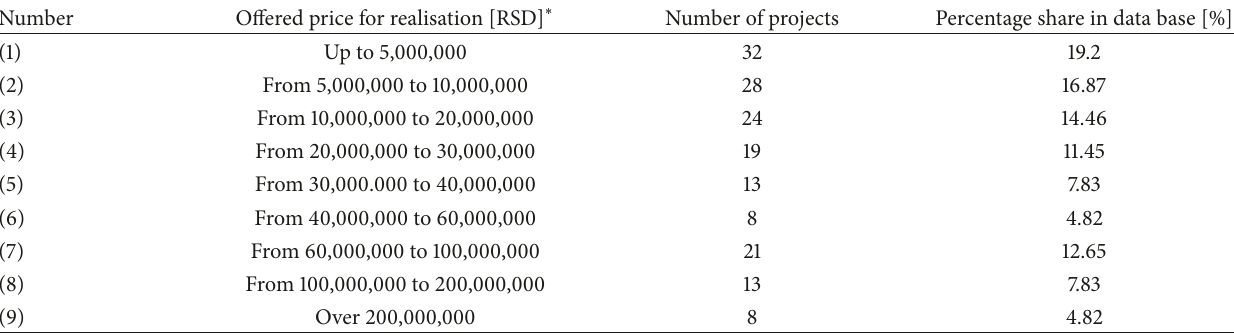
Table 3: Number of projects depending on the offered revalorised price for realisation of works.